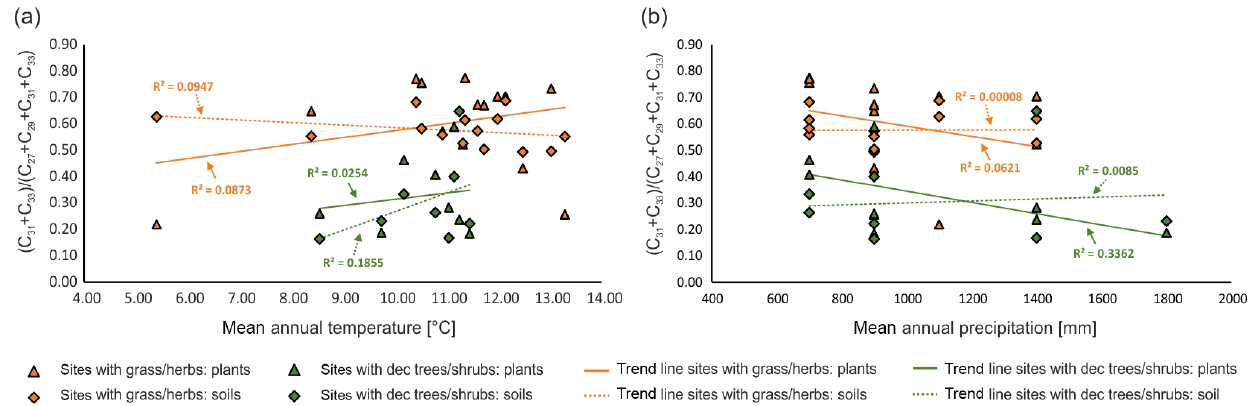
Figure 5. n -Alkane ratios from modern plant and topsoil samples plotted against (a) mean annual temperatures and (b) mean annual precip- itation. Dotted trend lines are linear regression lines for n -alkanes of modern plants from sites with grassland/herbs (orange) and sites with deciduous trees/shrubs (green), whereas solid trend lines refer to n -alkanes from